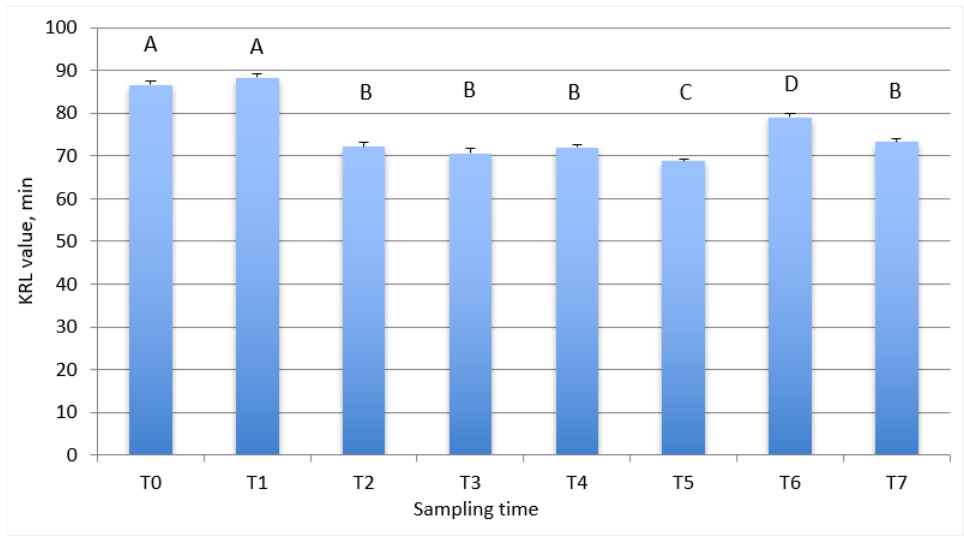
Figure 1. Total antiradicalic activity of whole blood in relation to the training program of the trotter horses. Data are reported as mean ± SEM. T0, start of taming period; T1, 60 days from start of taming period; T2, beginning of training period; T3, 60 days after the start of training period; T4, 120 days after the start of training period; T5, 180 days after the start of training period; T6, beginning of racing season; T7, 60 days after the beginning of racing season. A, B, C, D differs for p <